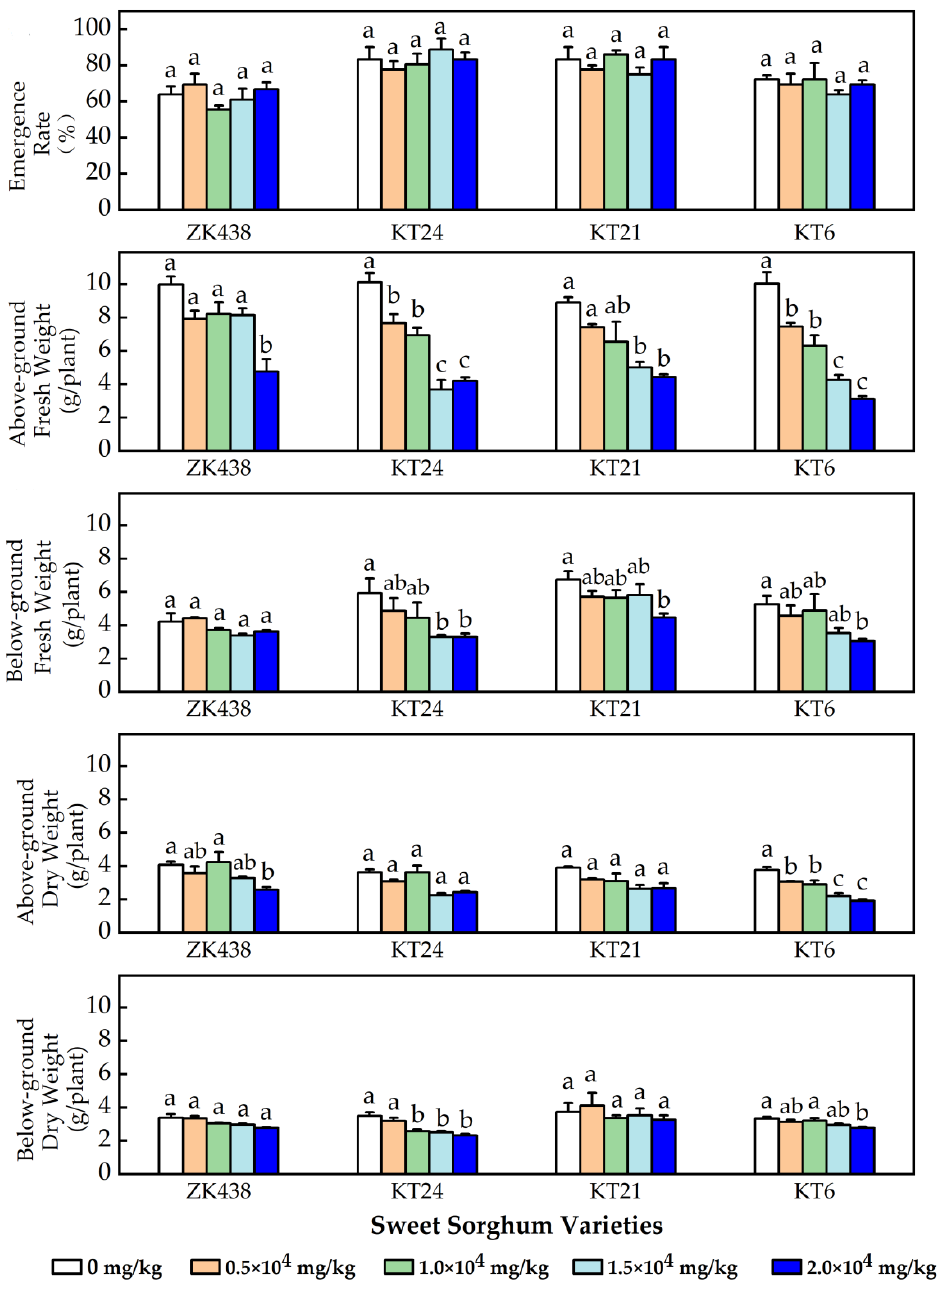
Figure 2. The effects of different contents of petroleum hydrocarbons in salinized soil on the growth of four varieties. (Different letters within the same S. bicolor variety indicated significant variances ( p < 0.05) among the different petroleum addition treatments.)